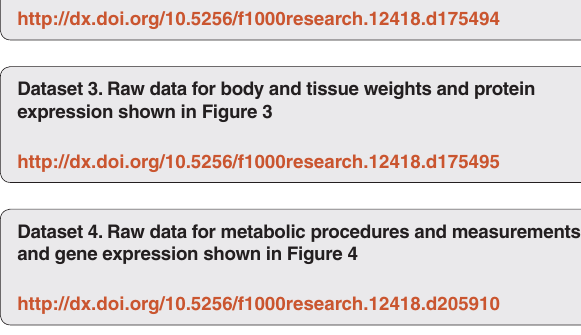
Dataset 2. Raw data for PI3K activity measurements and protein expression shown in Figure 2 http://dx.doi.org/10.5256/f1000research.12418.d175494